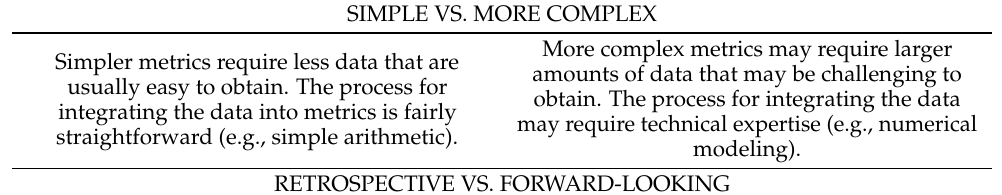
Table 1. Metric Trade-Offs